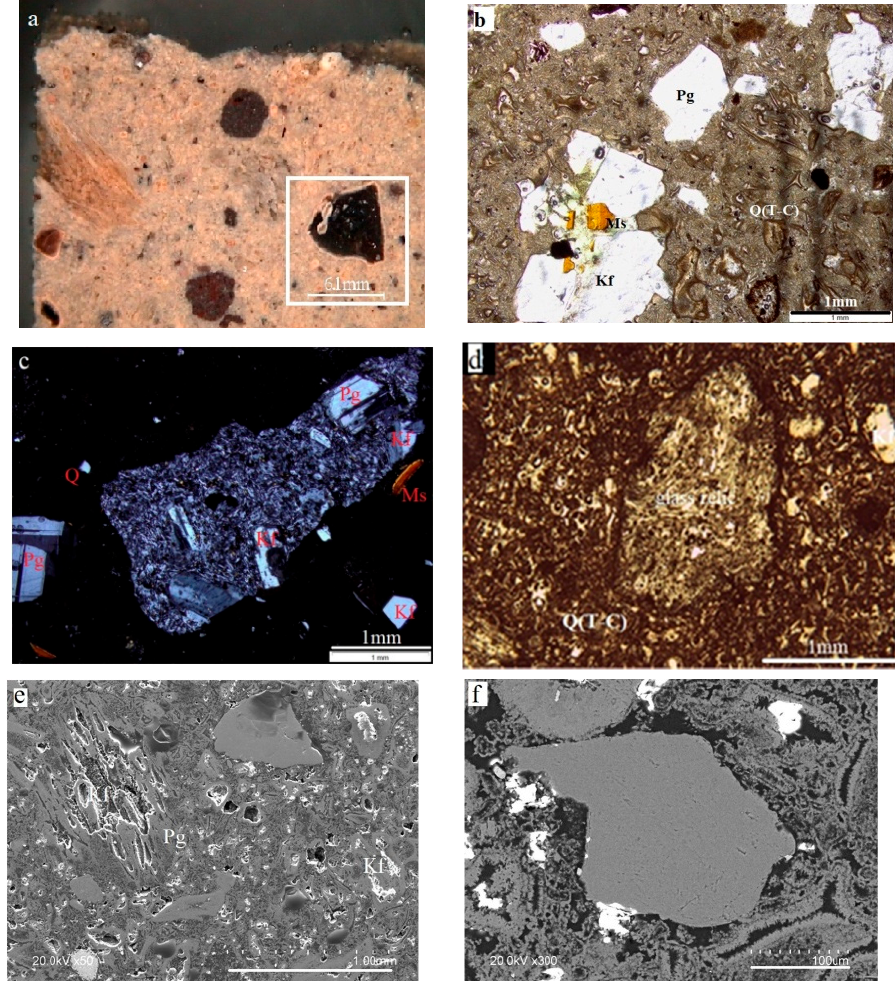
Figure 4. ( a ) Reactive belt; ( b ) OM-PPL of Wt ignimbrite; ( c ) XPL Be ignimbrite; ( d ) Pk ignimbrite, PPL